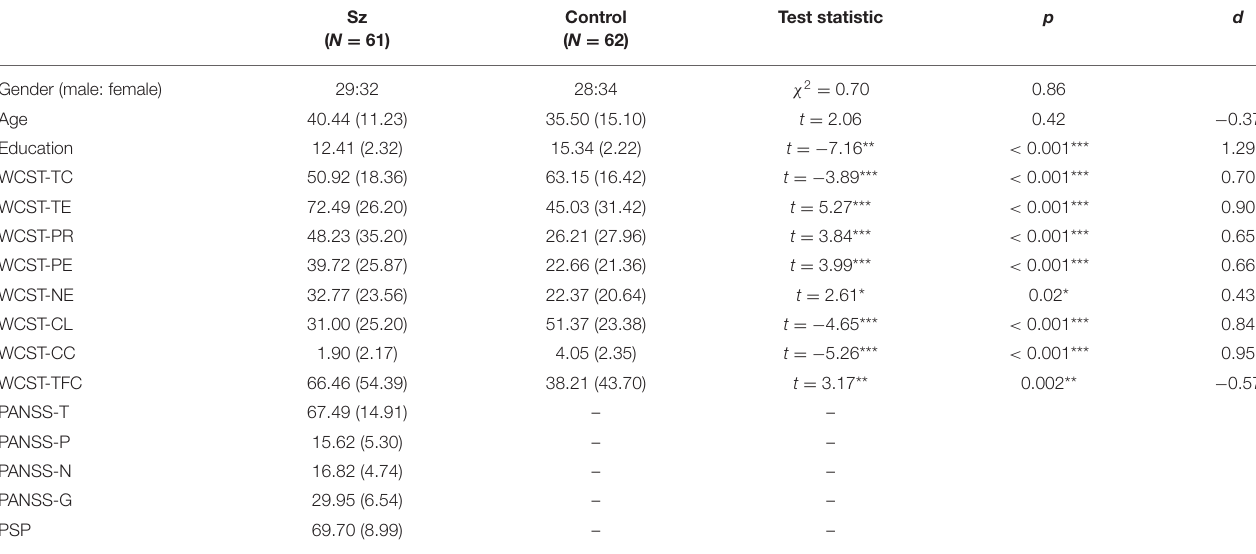
TABLE 1 | Demographic and clinical characteristics of participants.